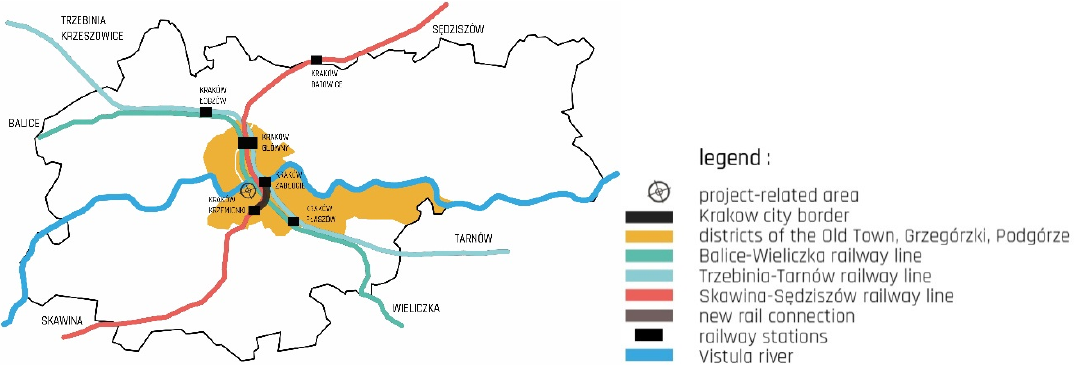
Figure 7. Railways in Cracow (Kraków), (elaborated by E. Latusek).